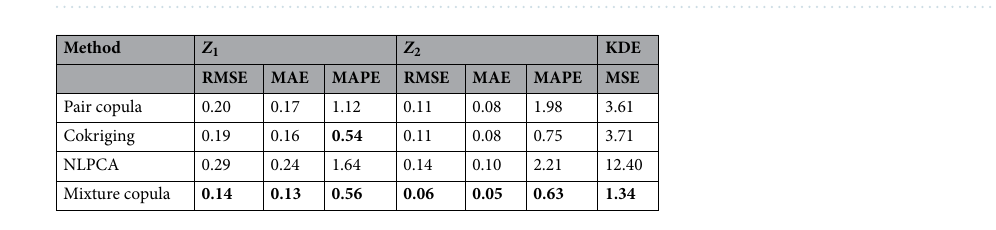
Table 5. Model validation in prediction of Z 1 and Z 2 . Significant values are in